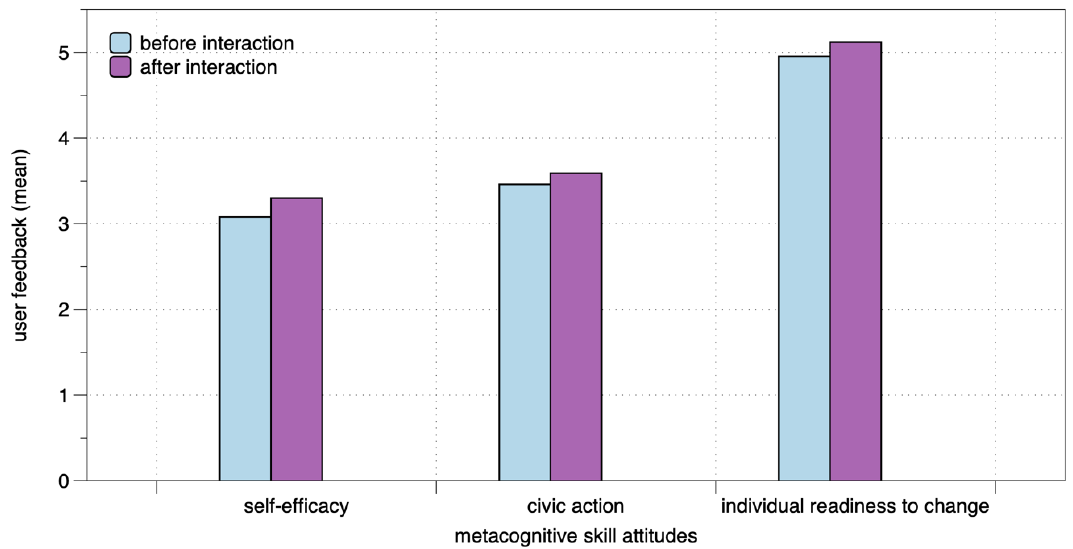
Figure 2. Self-efficacy, civic action and individual readiness to change before and after interaction.